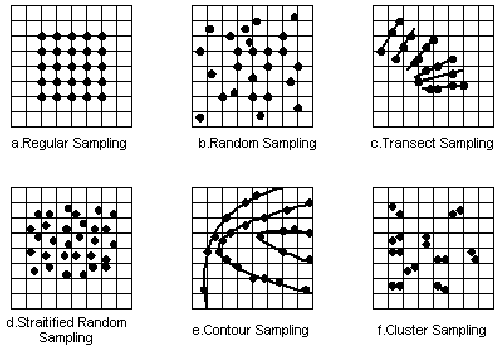
Figure 2. Sampling patterns: DEMs distributed in x and y plane.